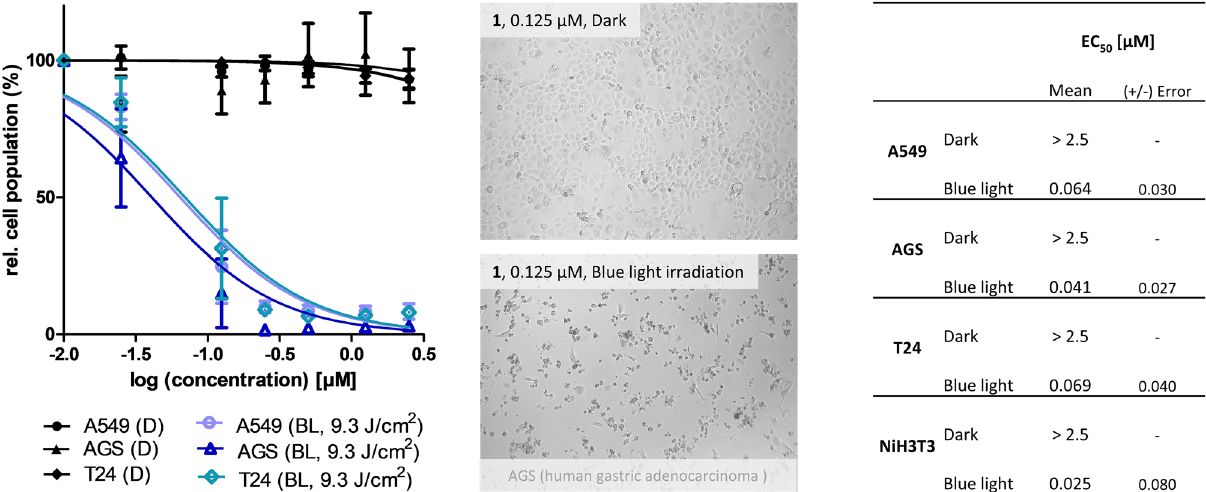
Figure 3. ( Left ) Dose–response curves of the three cell lines treated with 1 under blue light irradiation (λ exc = 468 nm blueish plots) and dark conditions (black plots). Error = standard deviation. ( Middle ) Micrographs (brightfield, 10× objective) of treated (and irradiated) cells. ( Right ) Results of the